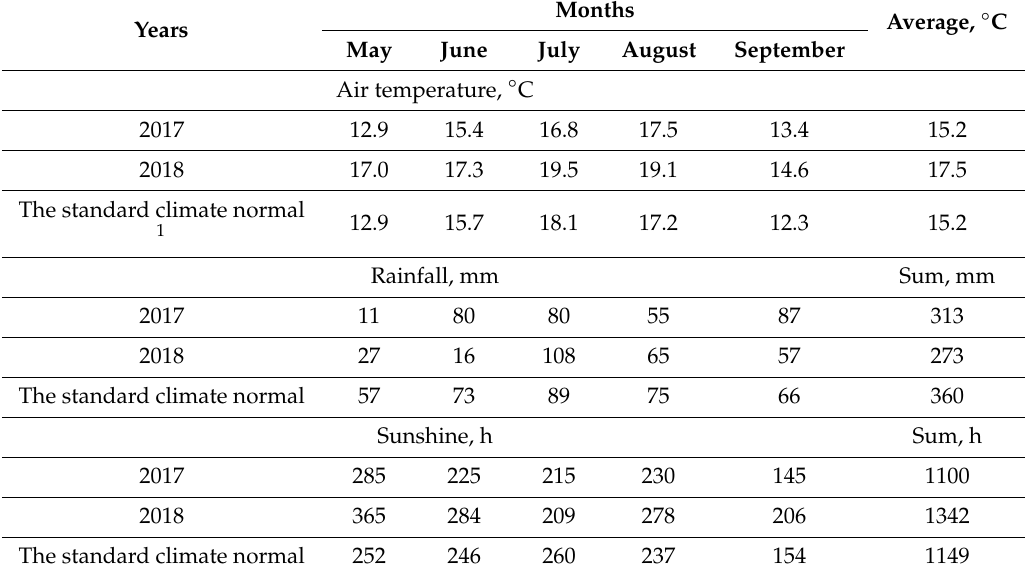
Table 5. Weather conditions for fireweed growing season 2017 and 2018 (Vilnius weather